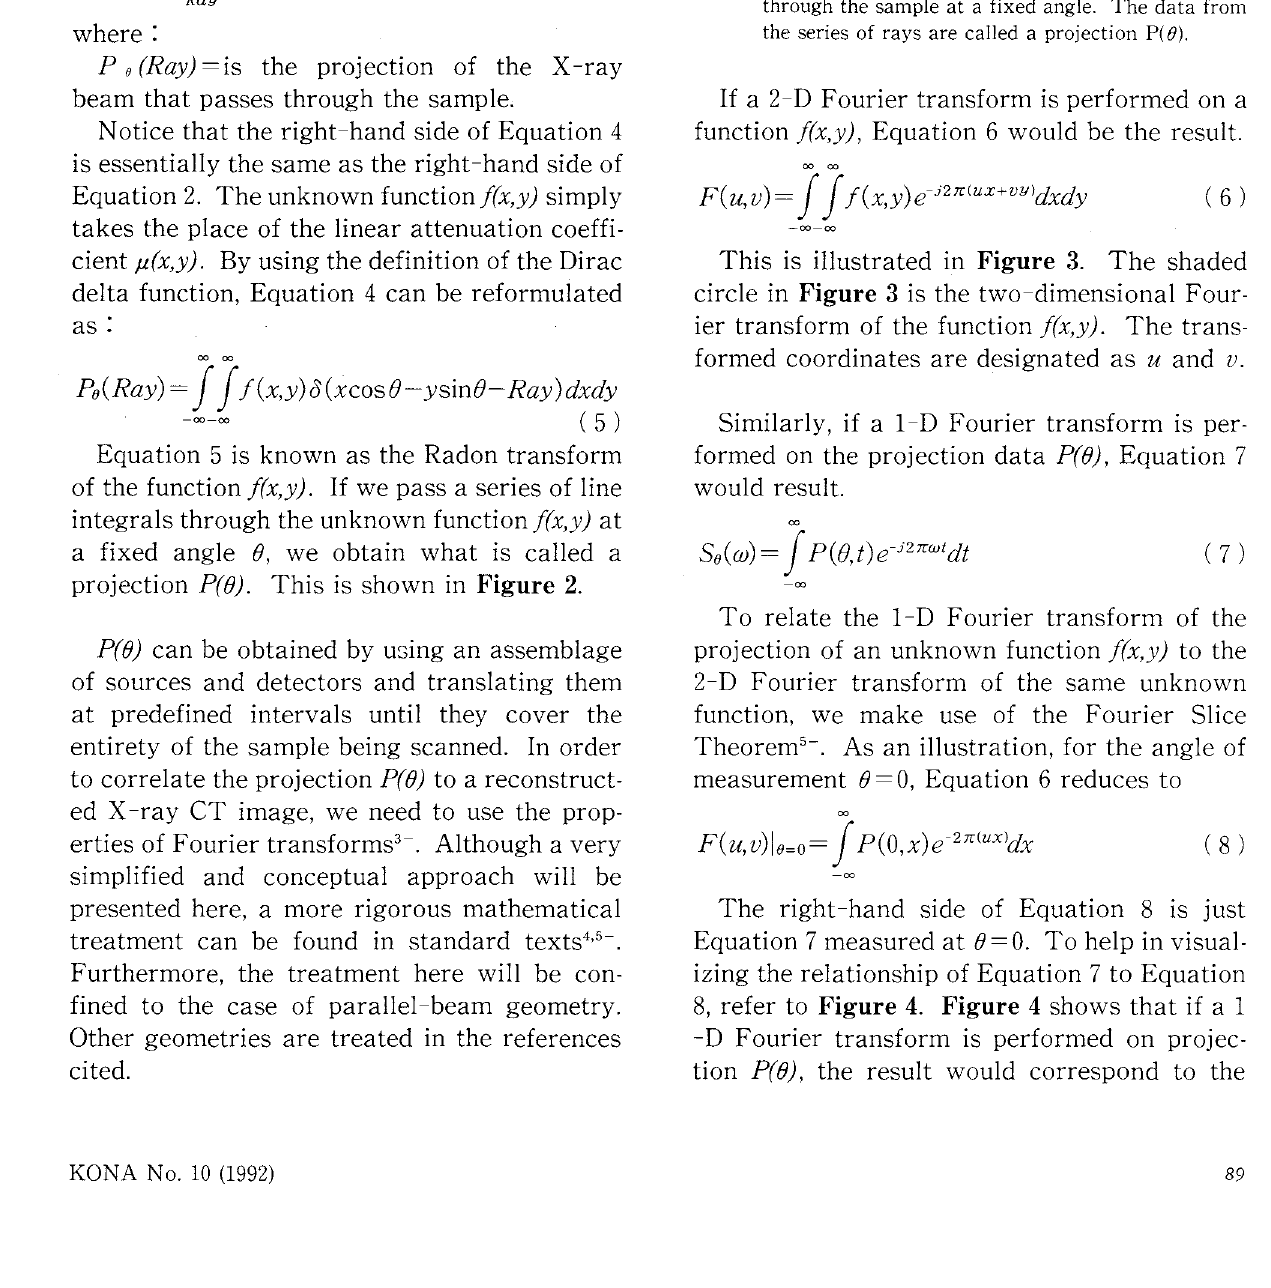
Fig. 2 An illustration showing several rays traversing through the sample at a fixed angle. The data from the series of rays are called a projection